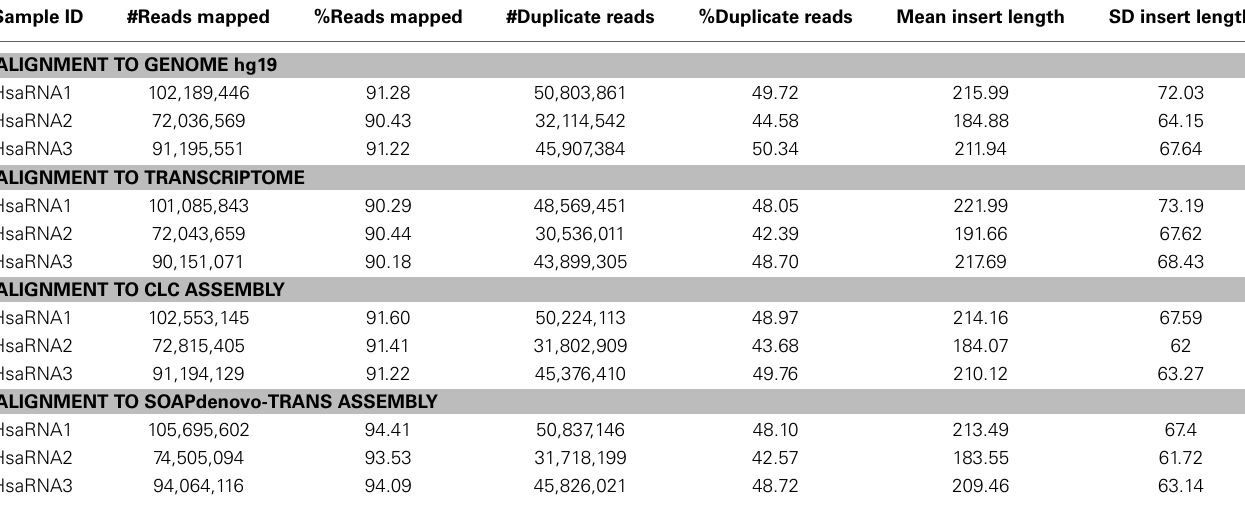
Table 4 | Mapping statistics for RNAseq